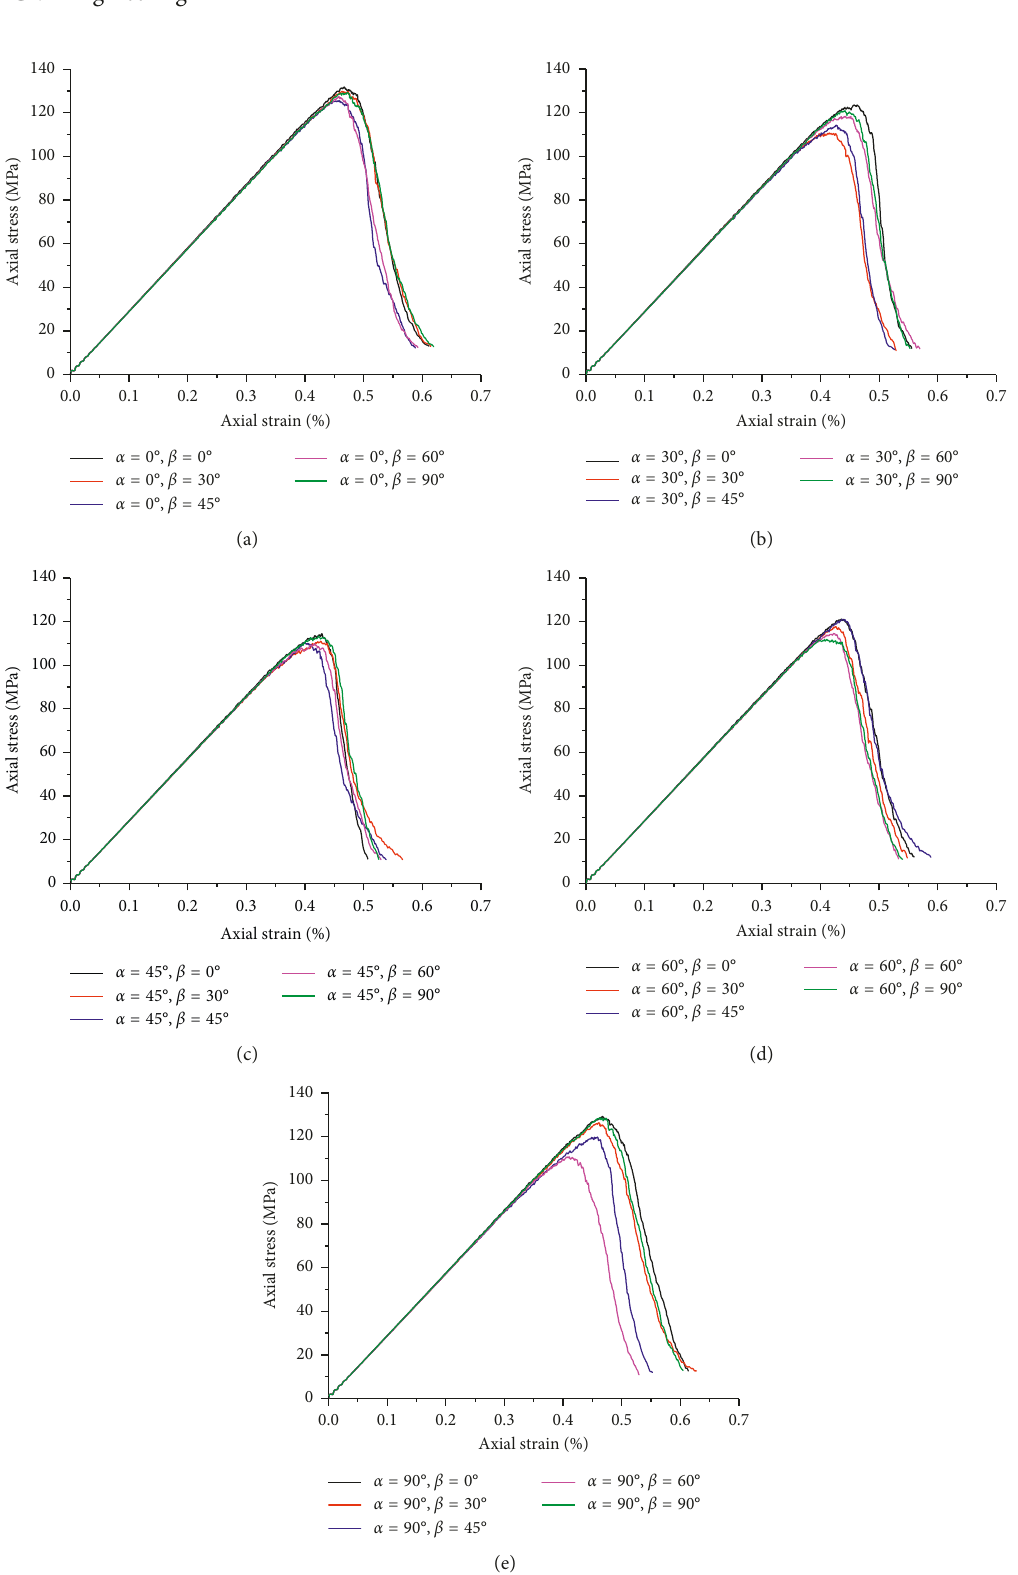
0 ° , (b) α 30 ° , (c) α 45 ° , (d) α 60 ° , and (e) α (cid:30) (cid:30) (cid:30) (cid:30)